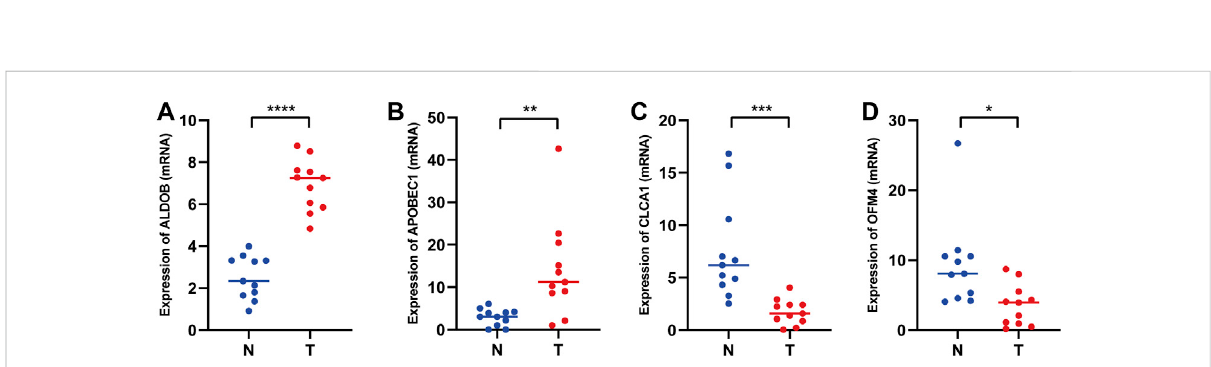
FIGURE 12 mRNAexpression levelsofglycolysis-andlactate-relatedprognosticgenesinCOADtissuesandadjacentnormal tissues. (A – D) RelativemRNA expression levels of ALDOB (A) , APOBEC1 (B) , CLCA1 (C) , and OLFM4 (D) in COAD tissues and adjacent normal tissues. T, COAD tissues; N, adjacent normal tissues. *p < 0.05; **p < 0.01; ***p < 0.001; ****p <